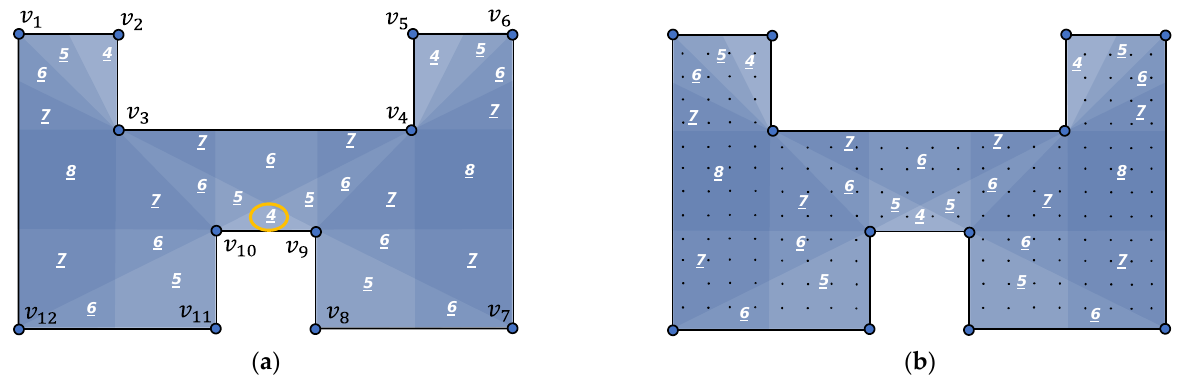
Figure 3. Visibility heatmaps. ( a ) Non-discretized heatmap; ( b ) discretized heatmap. Underlined numbers indicate the number of visible vertices.